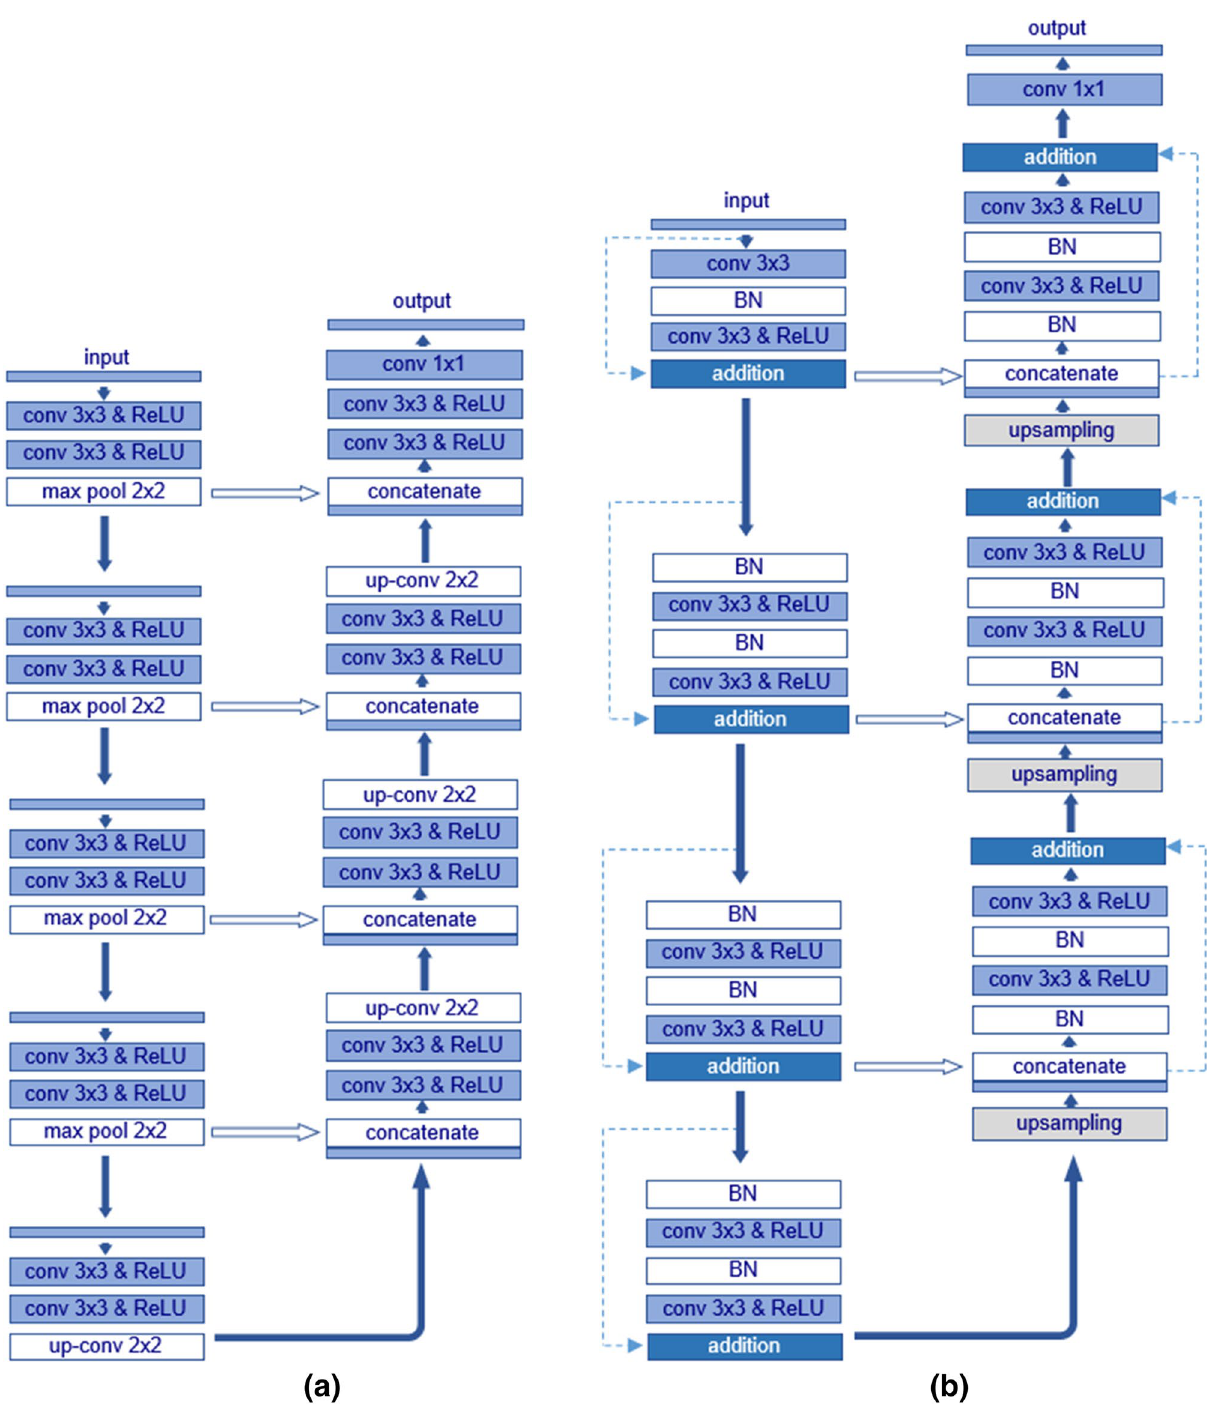
Figure 3. Architecture of the applied ( a ) U-Net and ( b ) ResU-Net in this